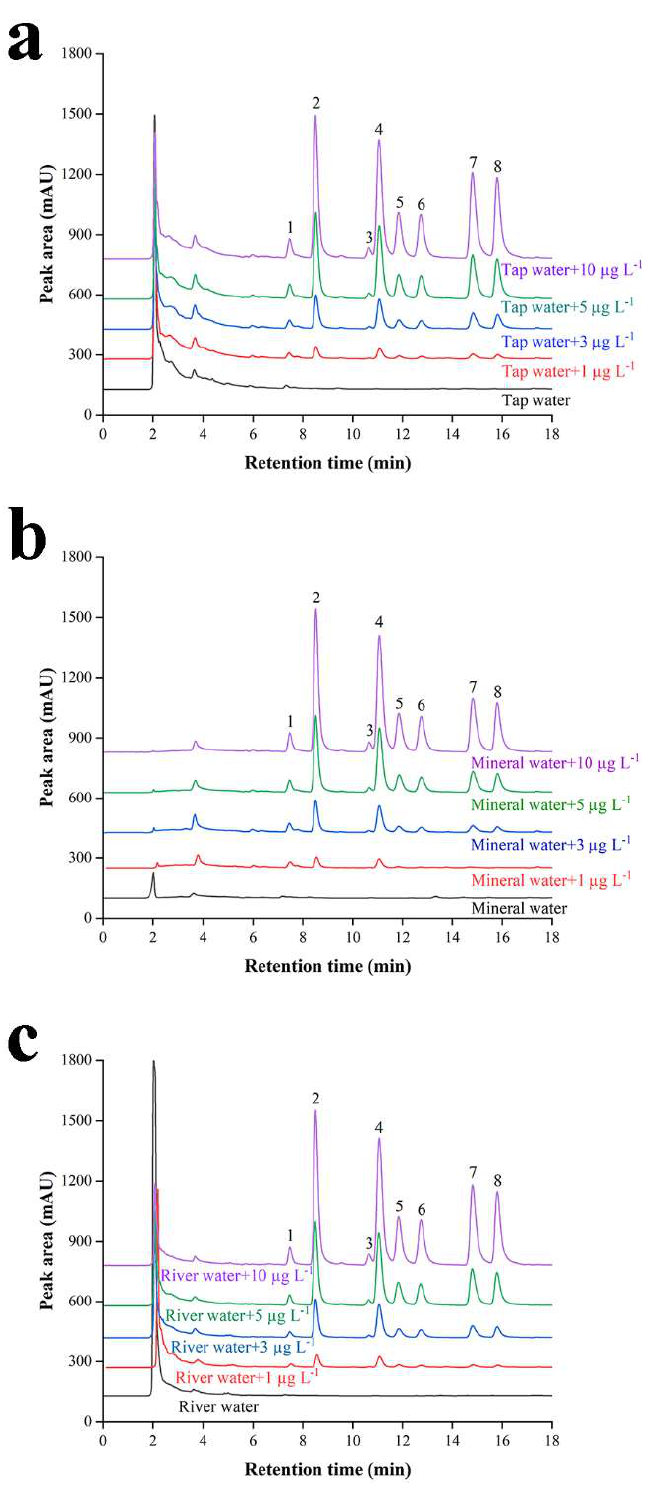
Figure 4. The chromatograms of real water samples including ( a ) tap water, ( b ) mineral water and ( c ) river water. Analytes: (1) Nap, (2) Acy, (3) Ace, (4) Flu, (5) Phe, (6) Ant, (7) Flt and (8) Pyr.